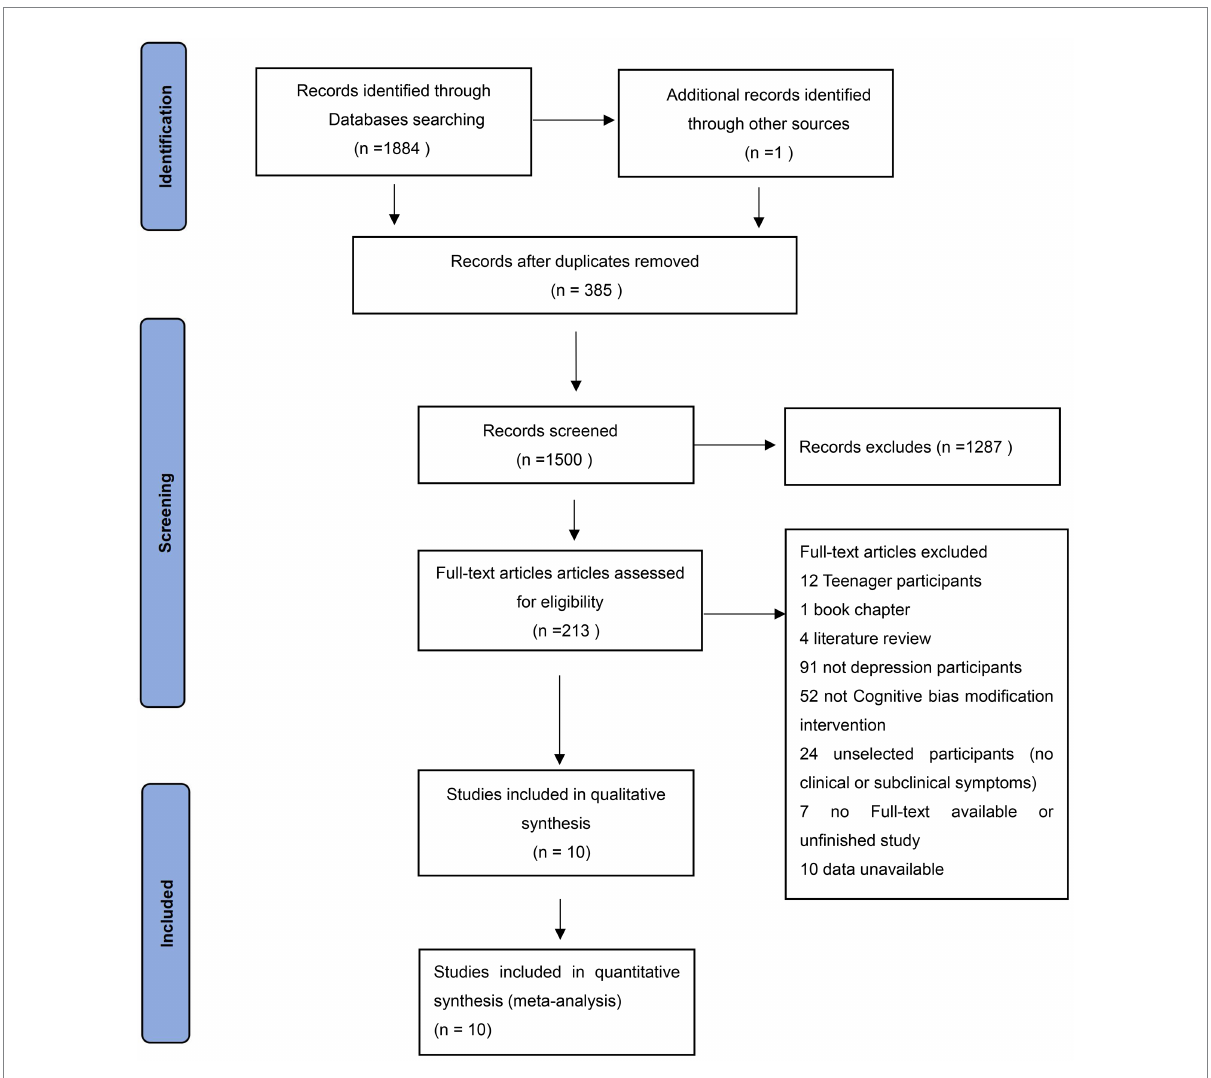
FIGURE 1 Follows the PRISMA statement. This is the flow chart included in the